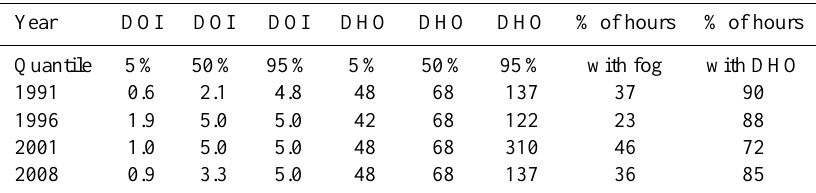
Table 4. As Table 2 but for the travel time of back trajectories over ice (DOI, days), and for median values of the Hoppel-diameter (DHO,nm). Additionally, the percentage of fog occurrences and of hourly size distribution records with Hoppel-diameter are given.